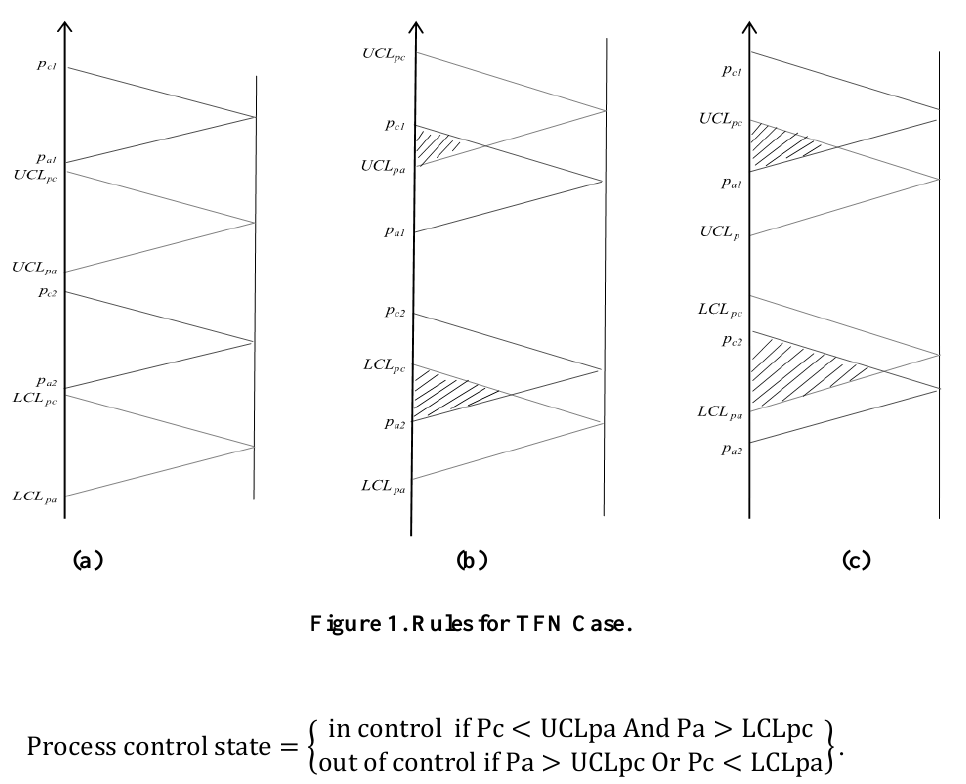
Figure 1. Rules for TFN